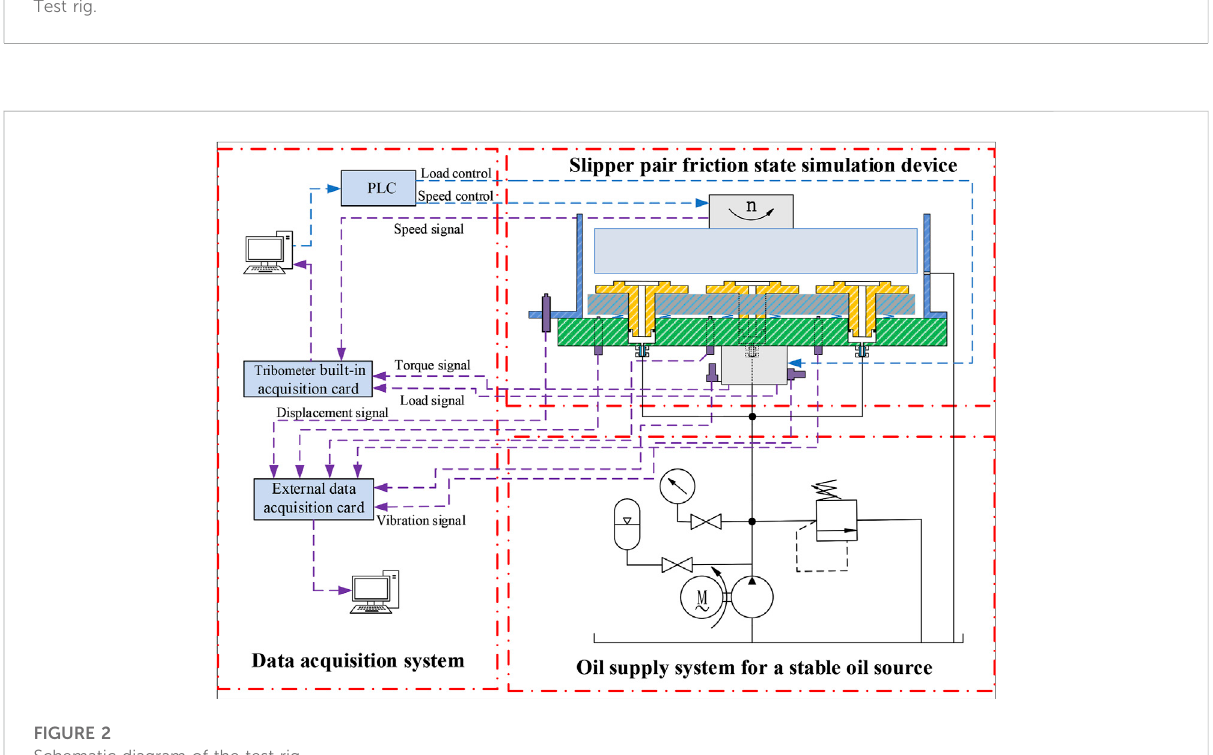
FIGURE 1 Test rig.